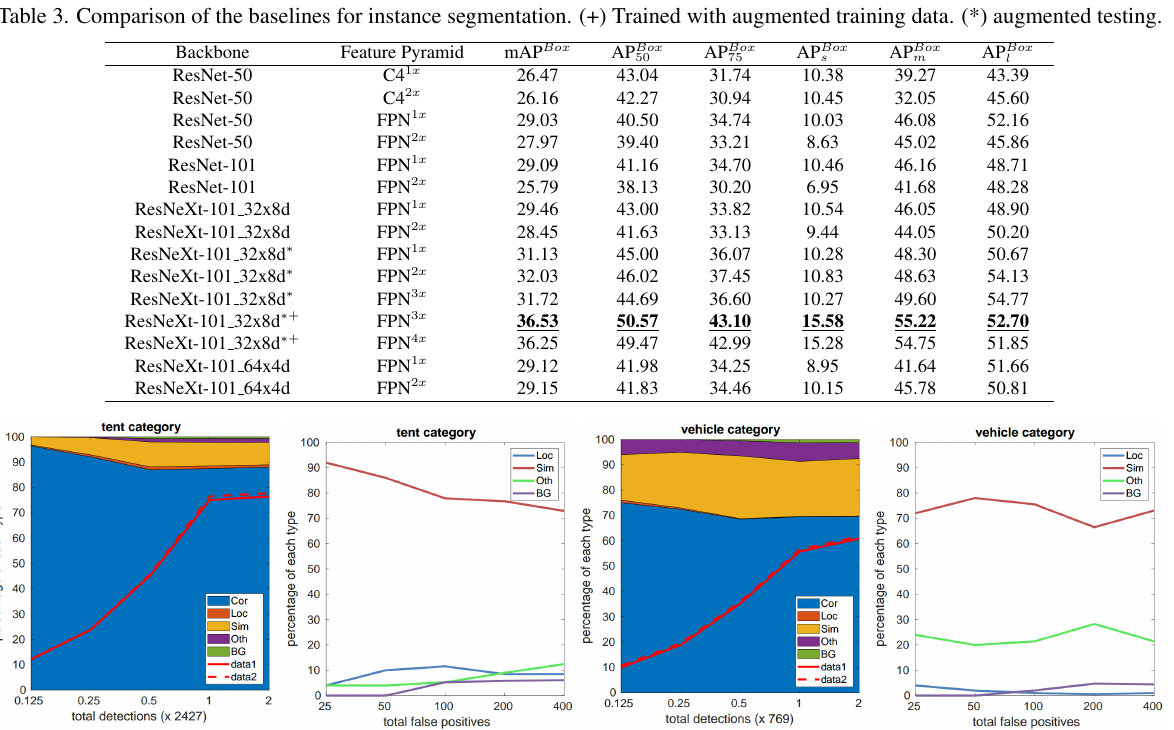
Figure 4. Performance visualization for the best Mask-RCNN setting on tent and vehicle categories from DLR-AerialTent test set.The first and third diagram from the left show the cumulative fraction of detections which were classified correctly (Cor), or represent false positive classifications due to poor localization (Loc), or due to confusion with similar (Sim), or with other (Oth) categories, or with the background (BG). The solid red line indicates the change of recall with the strong criteria of 0.5 (jaccard overlap) by increasing detection numbers. The dashed red line reflects the weak criteria of 0.1 (jaccard overlap). The diagrams on the right side indicate the distribution of top-ranked false positive